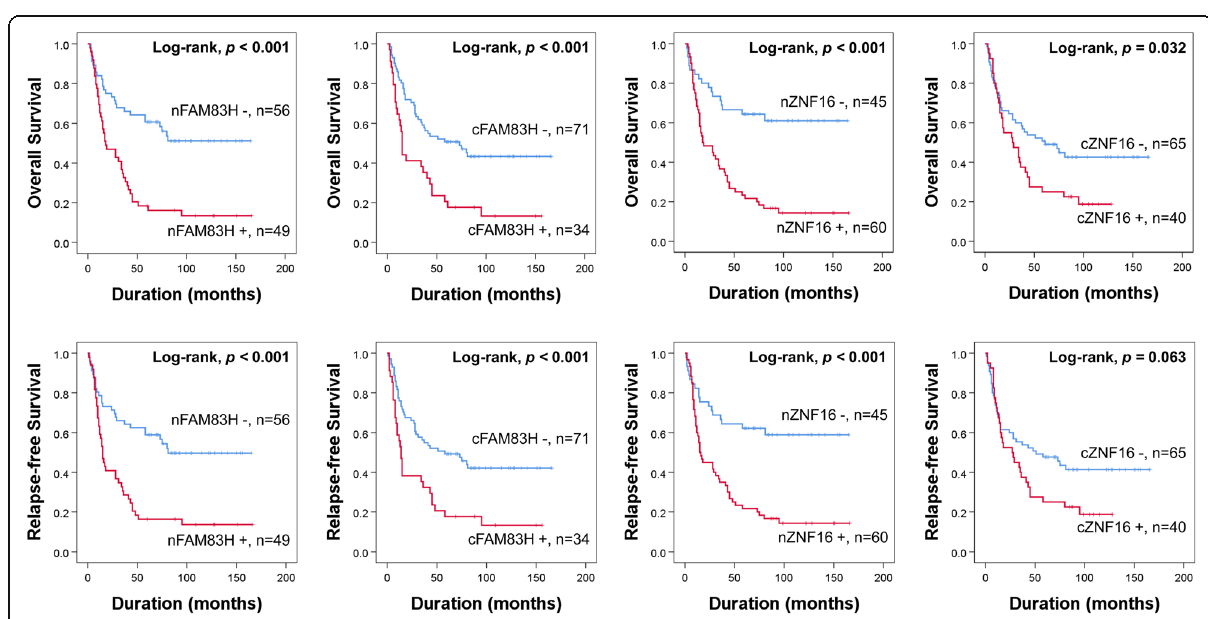
Fig. 2 Survival analysis according to the expression of FAM83H and ZNF16 in gallbladder carcinomas. Kaplan-Meier survival curves for overall survival and relapse-free survival of gallbladder carcinoma patients according to the expression of nuclear FAM83H (nFAM83H),